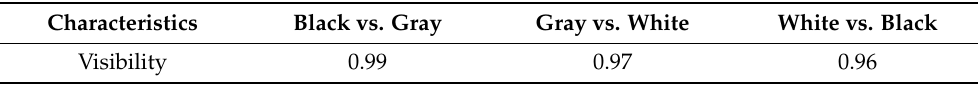
Figure 8. Afterimage visibility ( a ) in different backgrounds ( b ) with different exposure time and luminance level. Table 8. The correlation coefficient of visibility between each background.